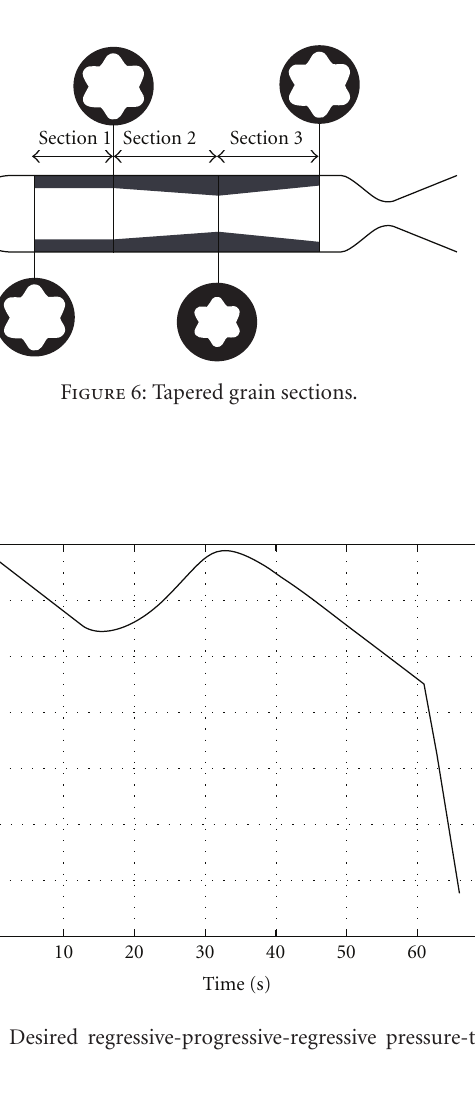
Figure 5: One-half of a single star point.